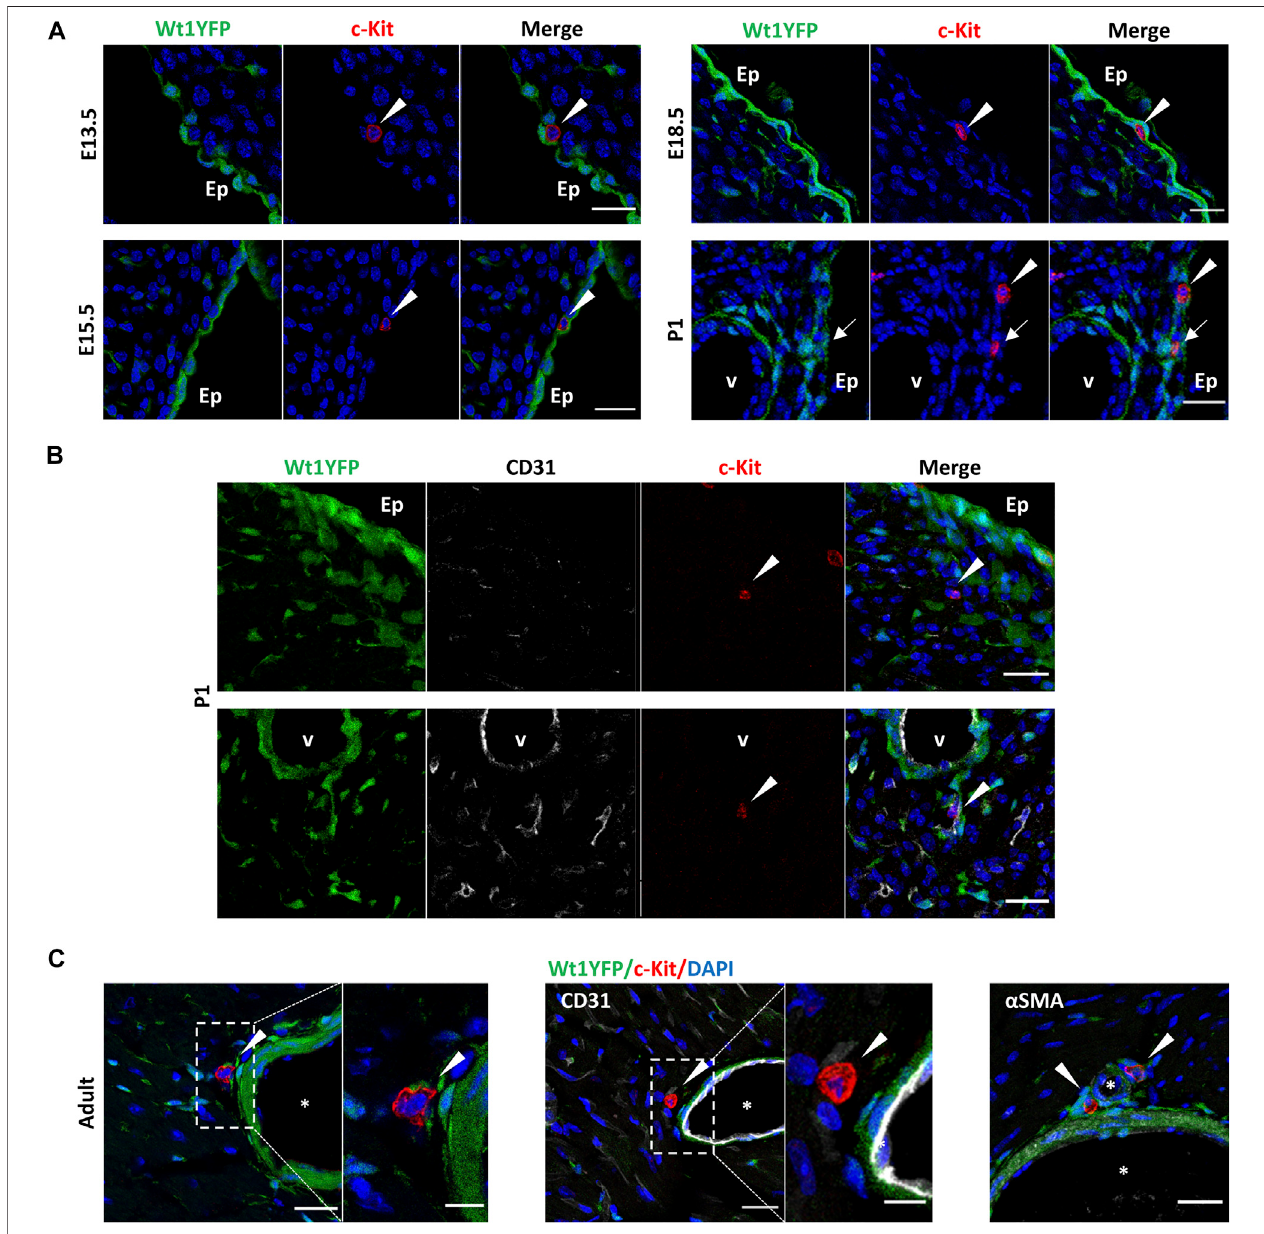
FIGURE 2 | Dynamic of the topological distribution of c-Kit POS cells in the embryonic, post-natal, and adult heart. Immunolocalization of c-Kit in the representative sections of Wt1Cre-YFP hearts, in which cells derived from the Wt1 epicardial lineage are constitutively expressed YFP (green). (A) c-Kit POS /YFP NEG cells (red) are present in the (sub)epicardium from E13.5 to postnatal stages (arrowheads). At P1, a few c-Kit POS /YFP POS cells (yellow) were detected in this region. (B) c-Kit POS / YFP NEG cells (red, arrowheads) were found in the cardiac interstitium and close to the coronary vessels (P1). (C) In the adult, c-Kit POS /YFP NEG cells (red, arrowheads) were localized next to the adventitia of large coronary vessels, close to α SMA POS /YFP POS smooth muscle cells (light green). Abbreviations: α SMA, alpha- smooth muscle actin; CD31/PECAM1, platelet, and endothelial cell adhesion molecule 1; c-Kit, KIT proto-oncogene receptor tyrosine kinase; DAPI, 4 ′ ,6-diamidino-2- fenilindol; Ep, epicardium; YFP, yellow fl uorescent protein. V, the lumen of coronary vessels. Scale bars: 25 μ m (A,B) ; magni fi cations in C: 10 μ m.